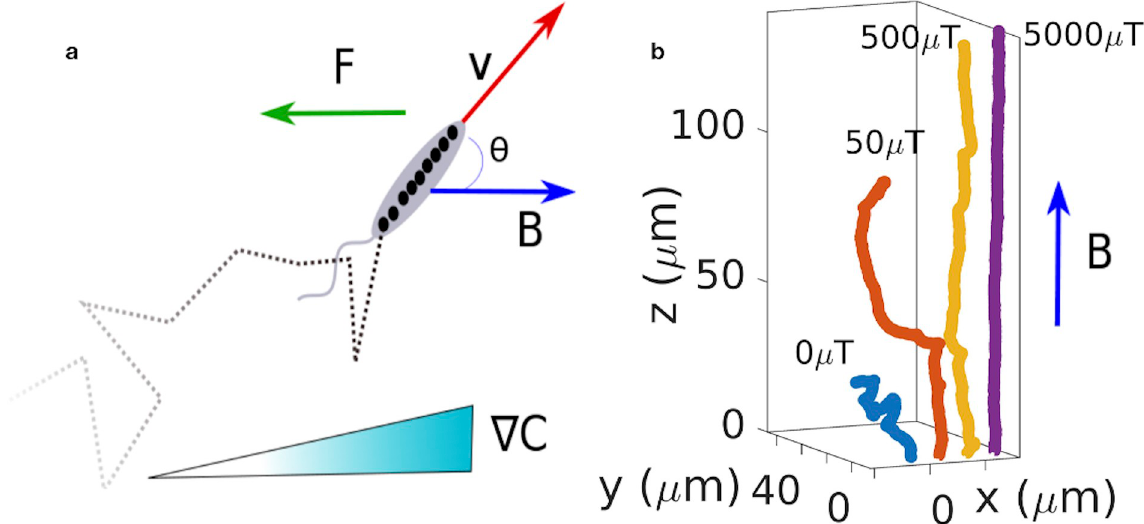
Fig 1. Model for swimming and chemotaxis in external fields. a) The model describes a bacterium that actively swims with velocity v, and that is subject to an external force F and a magnetic field B (measured in microTesla, μ T). Its random walk may also be biased to perform chemotaxis in a concentration gradient r C thanks to active changes of direction such as tumbles or reversals. b) Examples trajectories for run and tumble motion in the presence of a magnetic field. The magnetic interaction helps to reduce the motion of the bacteria to an effectively one- dimensional motion and directs it in the direction of the magnetic field. Active directional changes (tumbles) result in swimming in other directions, an effect that is increasingly suppressed with increasing intensity of the magnetic field.